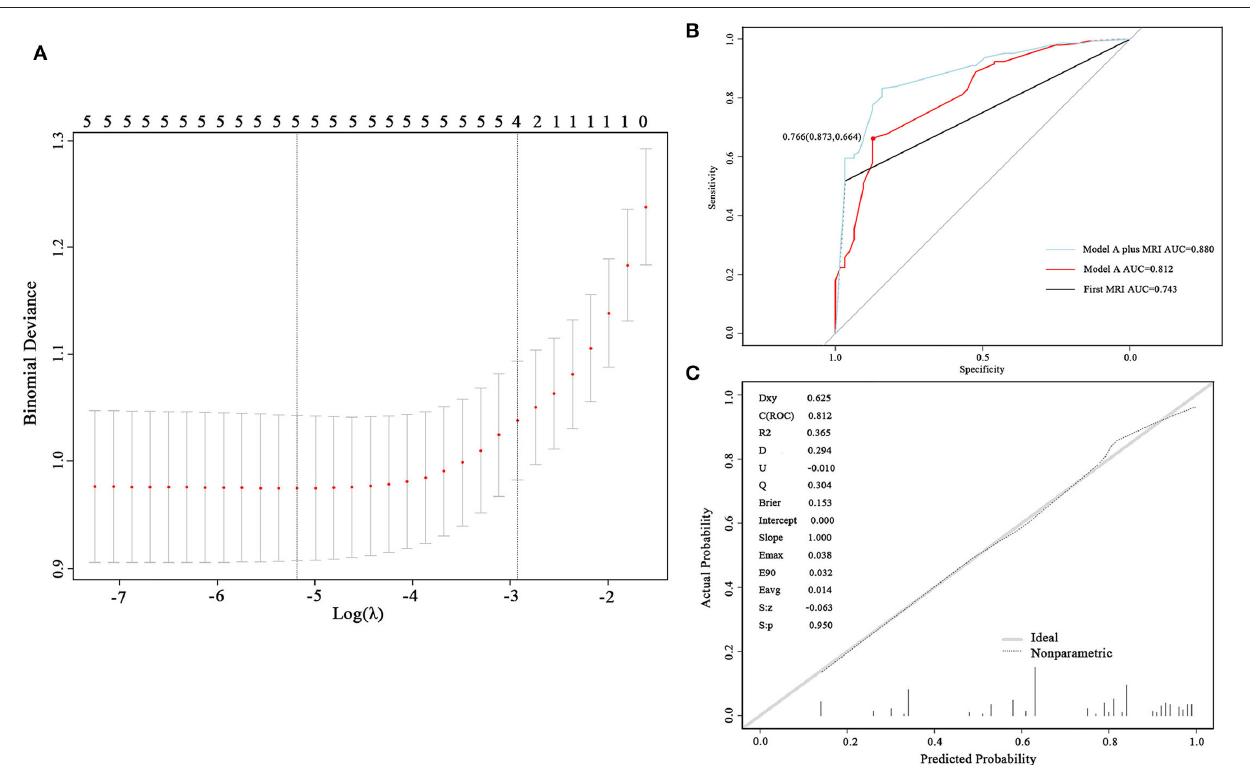
and the AUC value was 0.840 (95% CI: 0.777–0.902) and 0.771 (95% CI: 0.687–0.855), respectively ( Supplementary Material